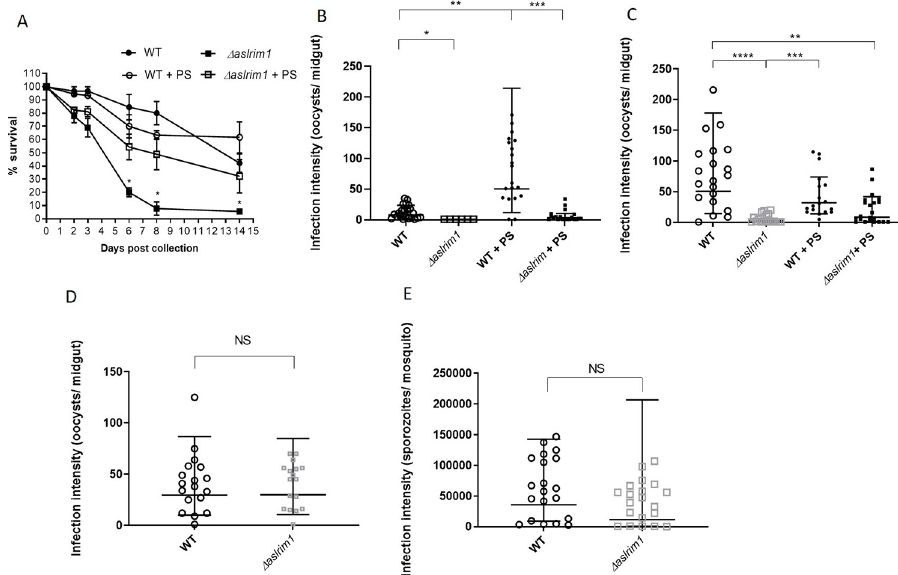
Fig 2. Effect of deletion of LRIM1 on mosquito longevity and Plasmodium falciparum infection intensity. (A) Survival of WT and Δ aslrim1 A . stephensi over a period of 14 days. Each point represents the mean ± SD of survival percentage in three different cages. The asterisks (p � 0.05) refer to the difference between WT and Δ aslrim1 grown with no PS, on days 6, 8 and 14. The data was analyzed with a non-parametric, Kruskal-Wallis and Dunn’s multiple comparisons tests. (B-C) Oocyst numbers in non-aseptic mosquitoes. Oocysts were counted by microscopy 7 days post bloodmeal for WT and Δ aslrim1 mosquitoes grown in non-aseptic conditions and fed on 15% sucrose with or without 1% penicillin/streptomycin (PS). The PS was added to the sugar meal for a short period (3- days prior to the bloodmeal) (B) or, throughout the entire adult life of the mosquitoes (C). Each point represents the oocyst number in a single midgut. (B) n = 22, 6, 20 and 20 for WT, Δ aslrim1 , WT + PS and Δ aslrim1 + PS, respectively. (C) n = 20, 19, 18 and 22 for WT, Δ aslrim1 , WT + PS and Δ aslrim1 + PS, respectively. The results were analyzed in non-parametric, Kruskal-Wallis and Dunn’s multiple comparisons tests. (D) The number of oocysts/midguts in WT and Δ aslrim1 mosquitoes grown under aseptic conditions, n = 18 and 17 for WT and Δ aslrim1 , respectively. The results were analyzed by the non-parametric, Mann Whitney test. (B-D) The results are expressed as a geometric means ± SD. Since some values were zero, a value of 1 was added to the entire dataset to allow calculation of the geometric means. (E) Number of sporozoites/mosquito in mosquitoes grown in aseptic conditions. The numbers of sporozoites were determined by dissecting the salivary glands of the mosquitoes and counting sporozoites from each mosquito by microscopy. The results are expressed as the geometric mean ± SD (n = 20 for both groups). The results for panel E were analyzed by the non-parametric, Mann Whitney test. For all panels, NS p > 0.05, � p � 0.05, �� p � 0.01 ��� p � 0.001, ���� p �